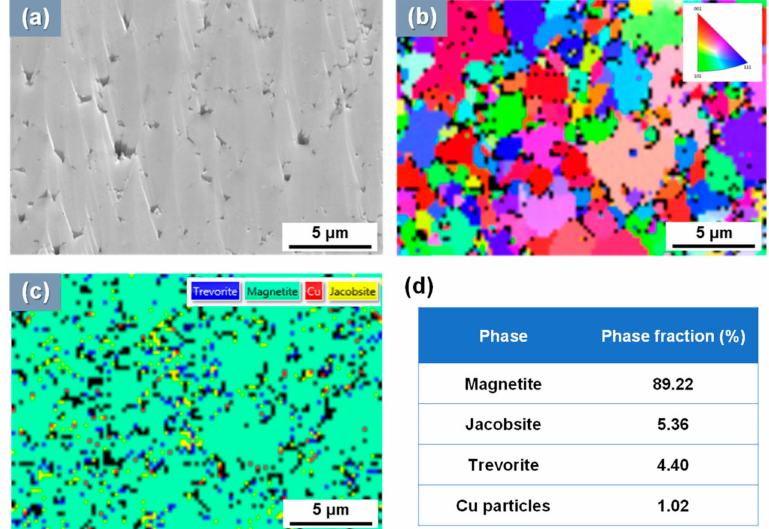
Figure 11. Electron back-scatter di ff raction (EBSD) data of the real SG tube flake: ( a ) SEM image, ( b ) 001 inverse pole figure orientation map, ( c ) phase distribution map, and ( d ) relative phase fractions.